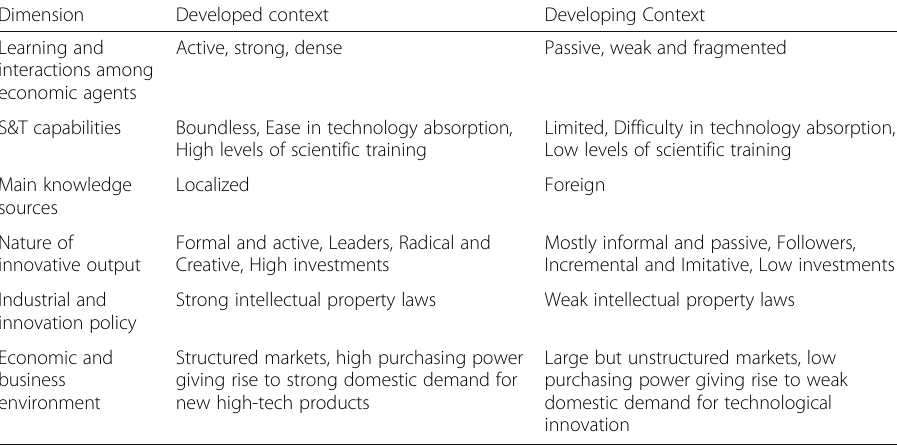
Table 3 Comparing innovation systems in developed and developing countries Dimension Developed